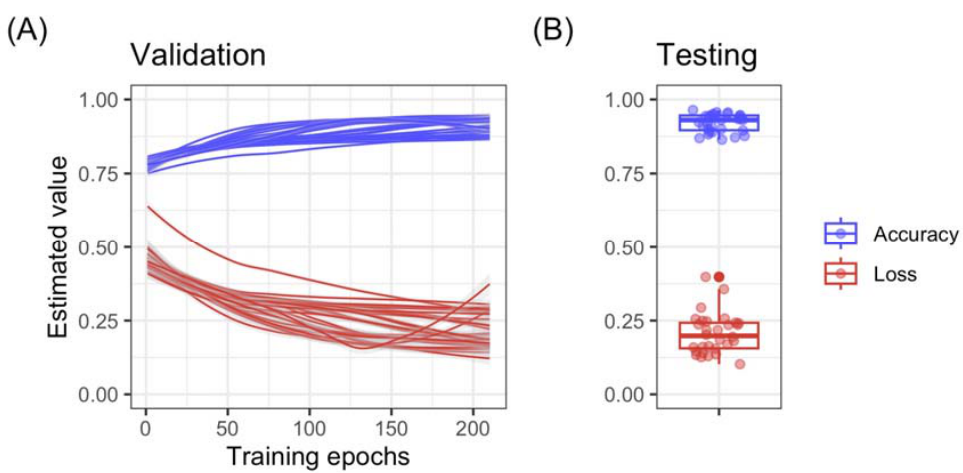
Figure 8. Accuracy and loss functions for 30 different convolutional neural network (CNN) training sessions. ( A ) refers to the validation set; it shows how accuracy and loss evolve over time; typically accuracy increases and loss decreases over epochs. ( B ) shows the final performances on the testing set (a subset of data that was not used for training). Data indicate that both validation and testing performances remain homogeneous over multiple ( n = 30) randomly initiated training sessions, indicating that the CNN is properly tuned, the architecture is appropriate for the data, and performances are replicable.